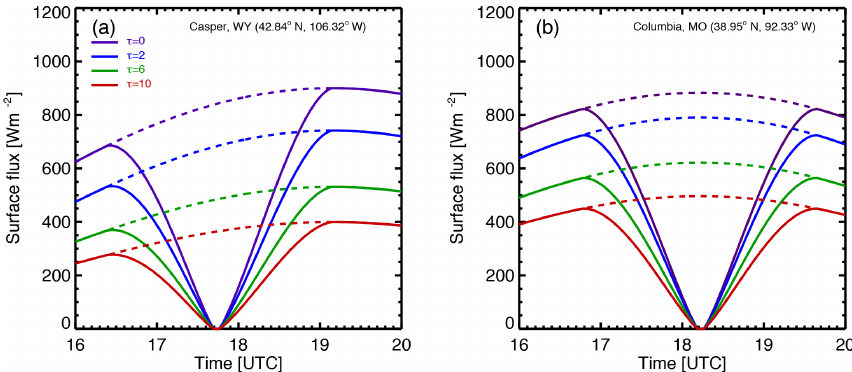
Figure 8. (a) Casper; (b) Columbia. The modeled surface SW flux variations for eclipse (solid lines) and non-eclipse (dashed lines) conditions for different cloud optical